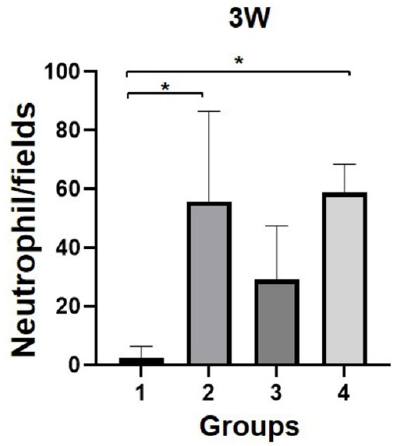
below the corneal basement membrane in group 1. In contrast, α -SMA was widely de-